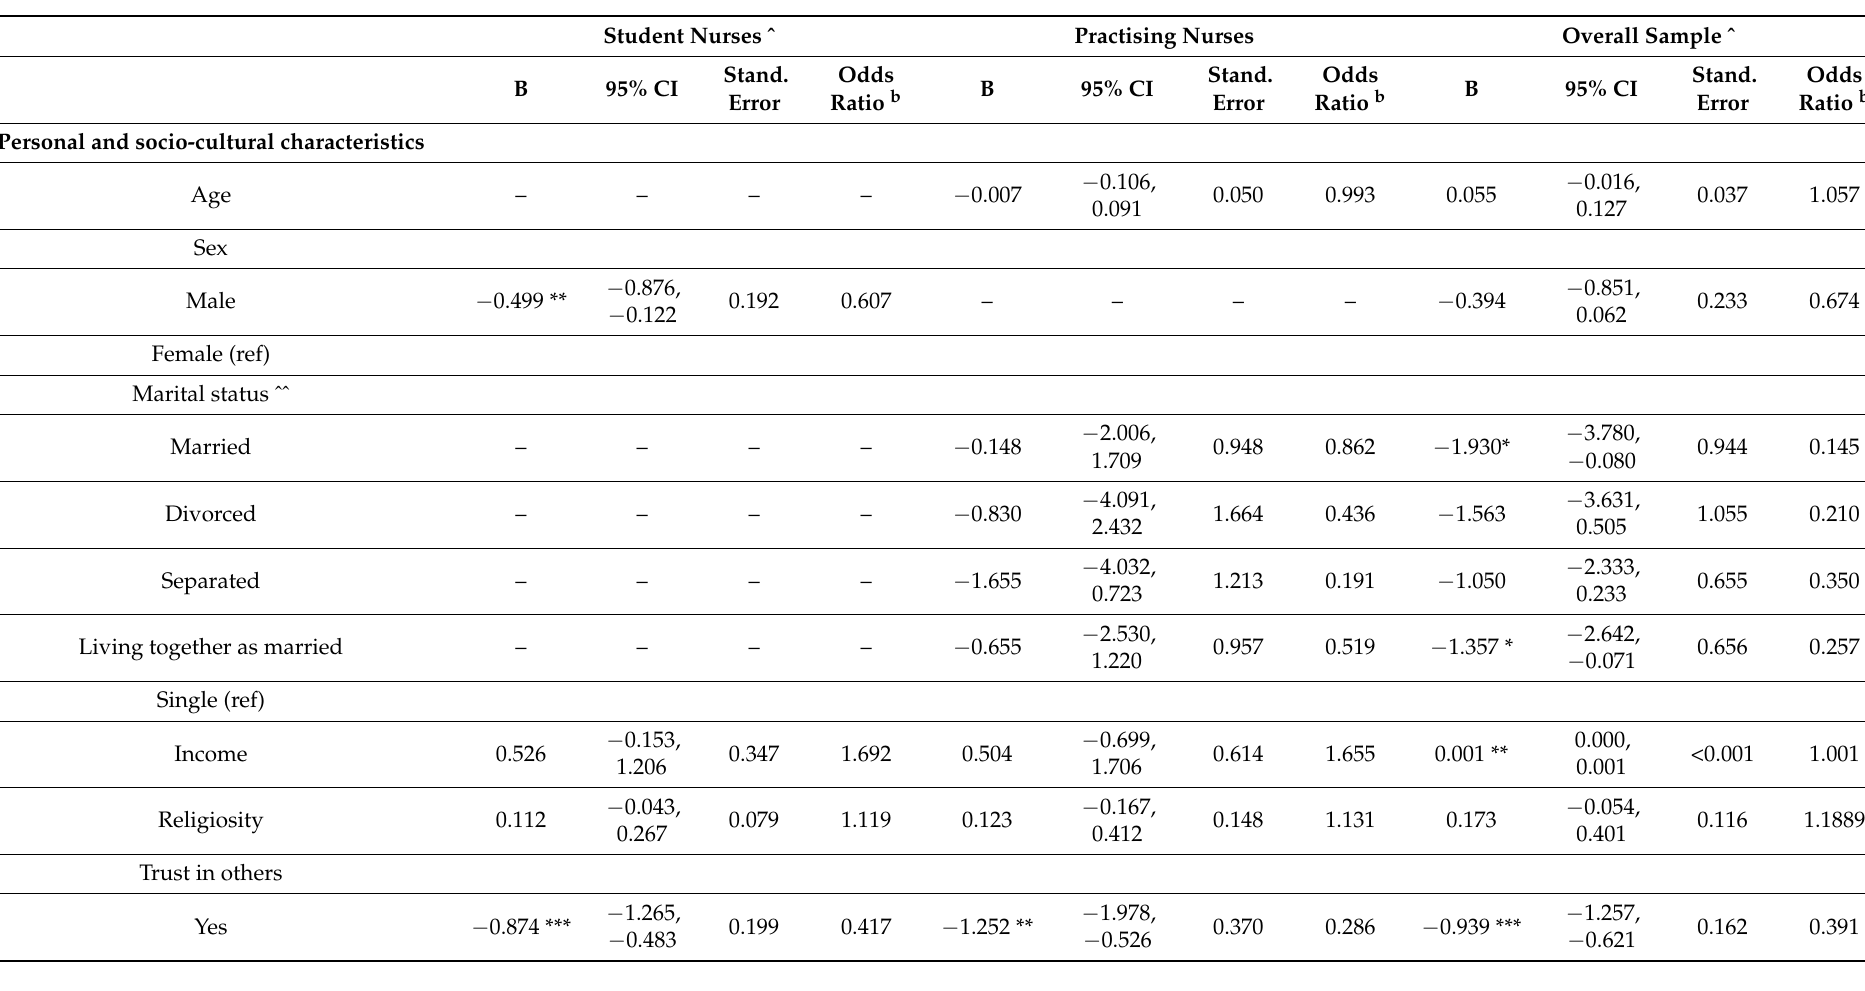
Table 2. Factors associated with health literacy knowledge among student and practising nurses in Ghana by ordinal logistics regression